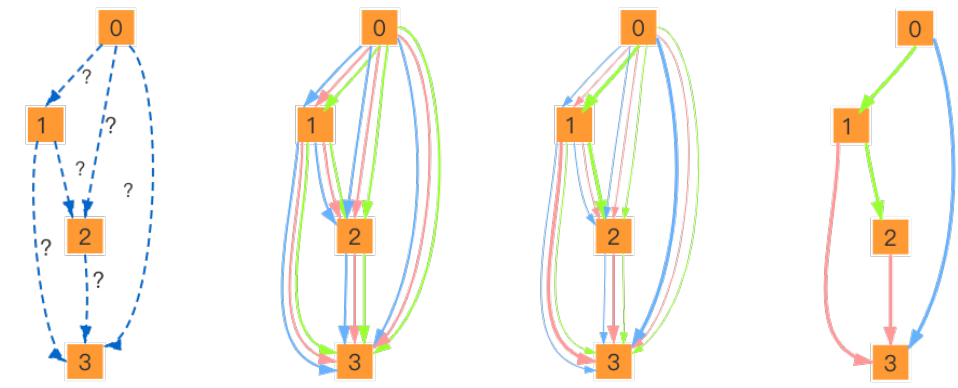
Figure 2. An overview of DARTS. First, initialize a supernet with random network weights w and unknown operations on the edges. Then, there is continuous relaxation of the search space by placing a mixture of candidate operations and jointly learning architecture α and the network weights w by finding α ∗ that minimizes the validation loss. Lastly, derive the final architecture based on the learned α